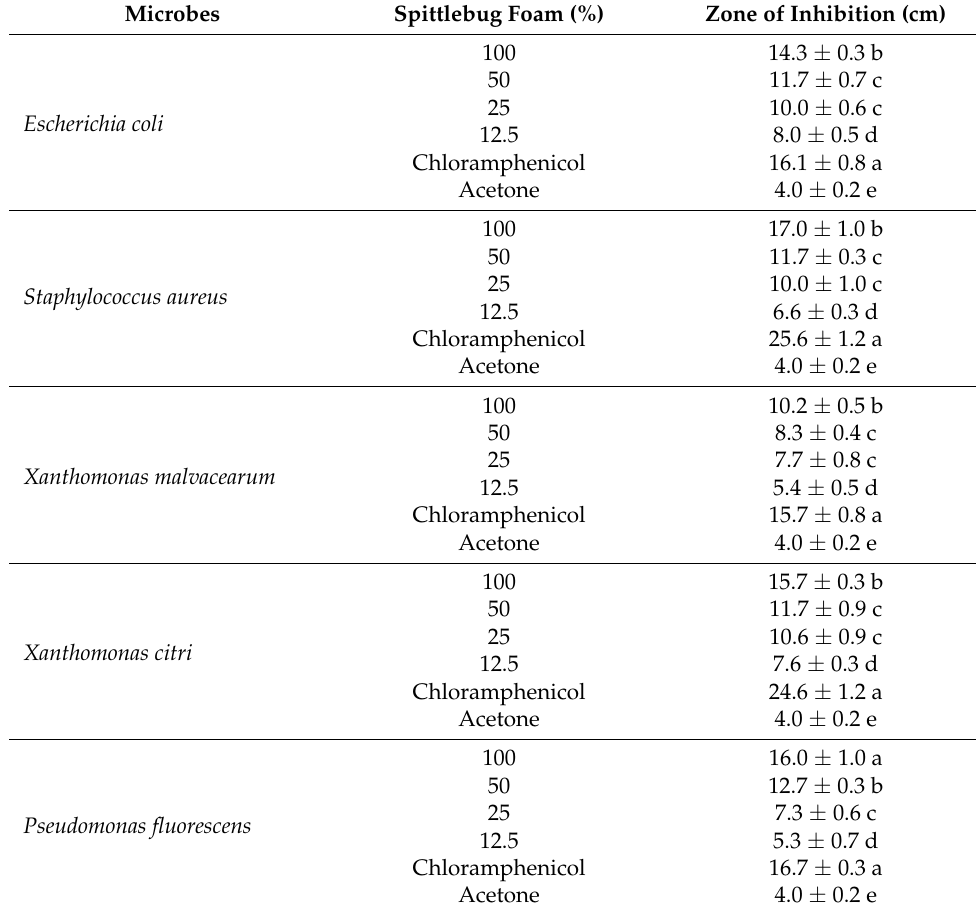
Table 8. Impact of different concentrations of P. costalis foam (100, 50, 25 and 12.5%) on antibacterial activity against Escherichia coli , Xanthomonas malvacearum , Xanthomonas citri , Staphylococcus aureus and Pseudomonas fluorescens . Chloramphenicol was the positive control, whereas acetone was the negative control. Same lowercase alphabet for each microbes was statistically significant at 5%.